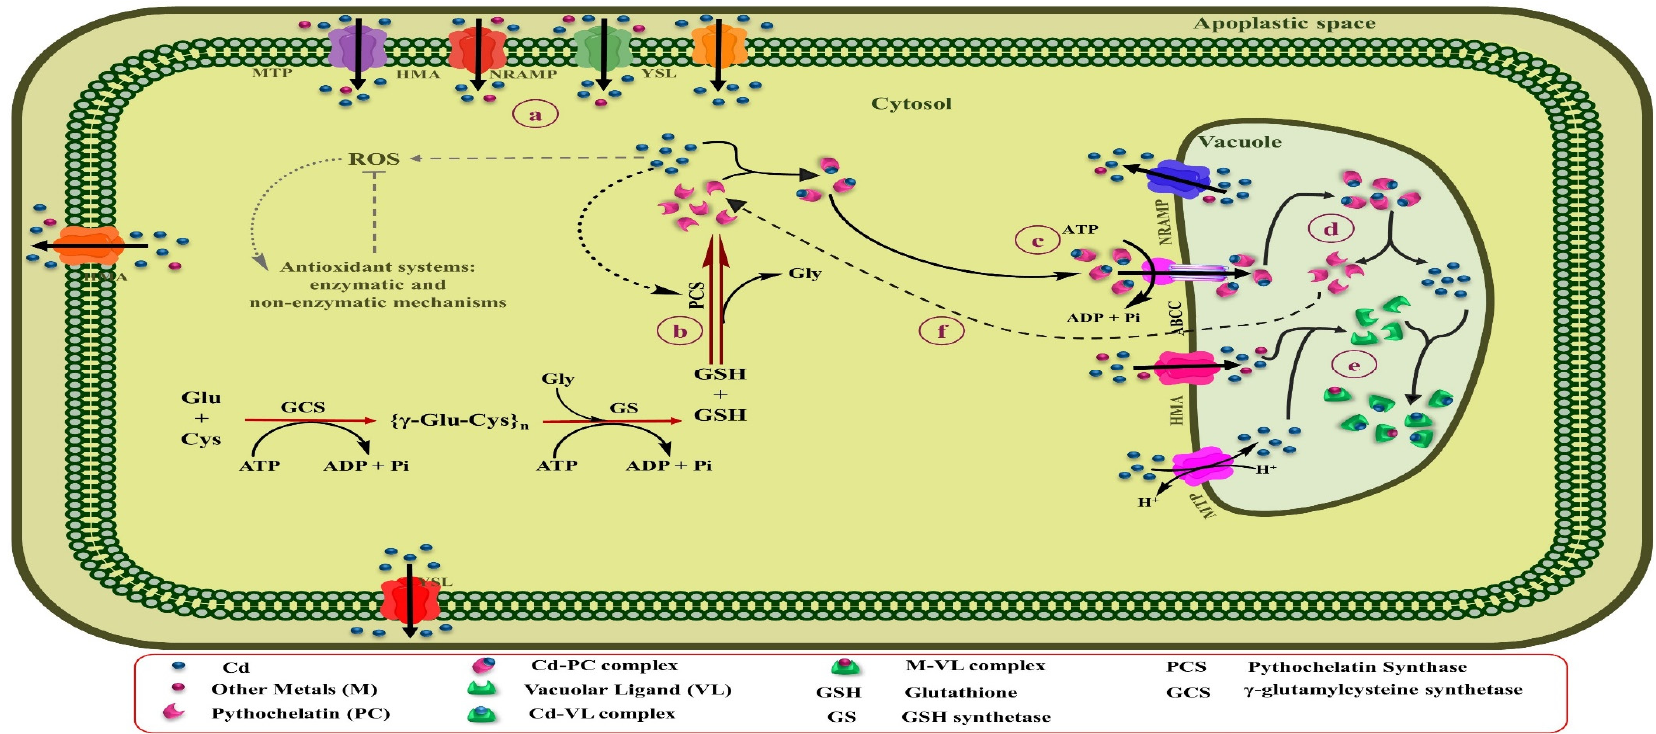
Figure 4. Schematic overview of Cd tolerance and its accumulation by PCs in leaves cells of Cd-hyperaccumulating plants. ( a ) Elevated Cd concentration inside the cytosol. ( b ) The Cd can be directly bound to the PCS and stimulate the biosynthesis of PCs from GSH by activating this enzyme. ( c ) Once the Cd-PCs complexes are formed, they can finally be sequestered within vacuoles by transferring ABC transporters through the tonoplast. ( d ) Due to the low pH of vacuoles, Cd-PCs complexes disassociate, and Cd can be stabilized in vacuoles by binding to ligands, including organic acids and probably amino acids. ( e ) PCs may be by destroyed hydrolase enzymes inside the vacuole or returned to the cytosol, where they able to keep their role as Cd shuttles.